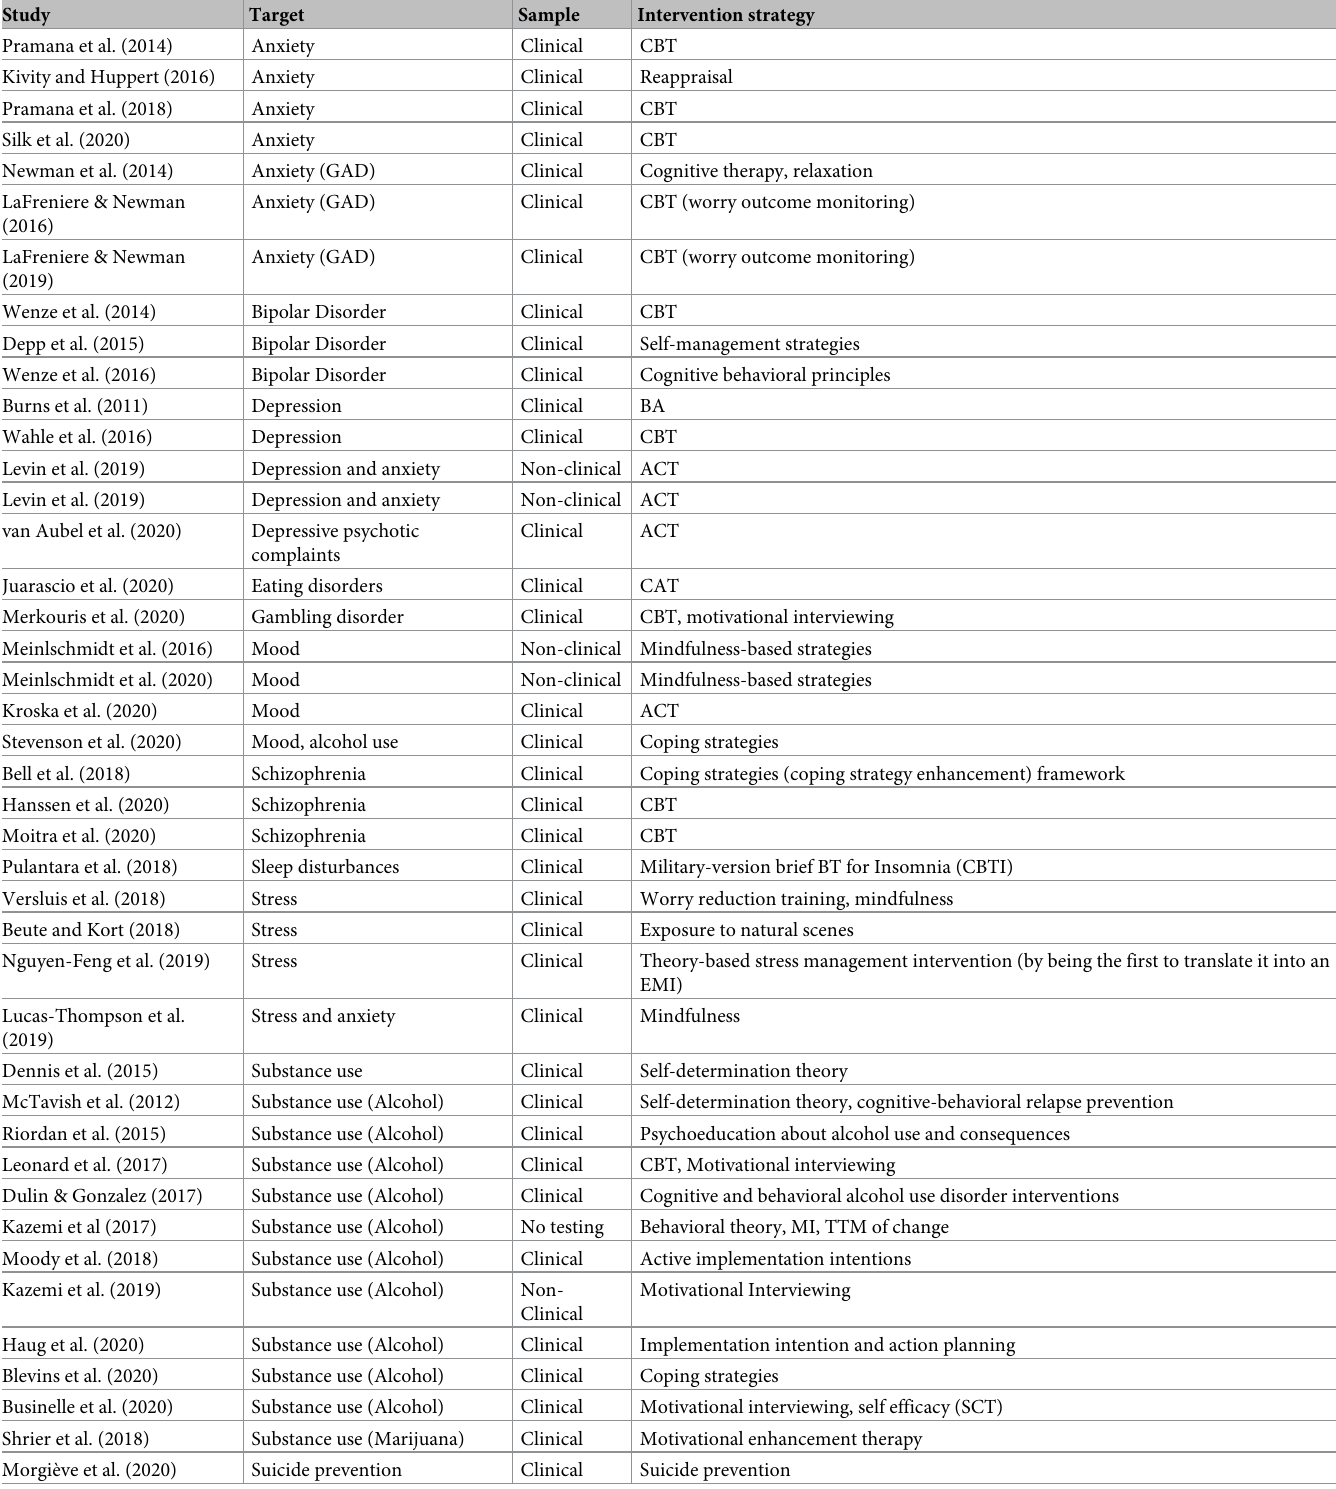
Table 1. Ecological momentary